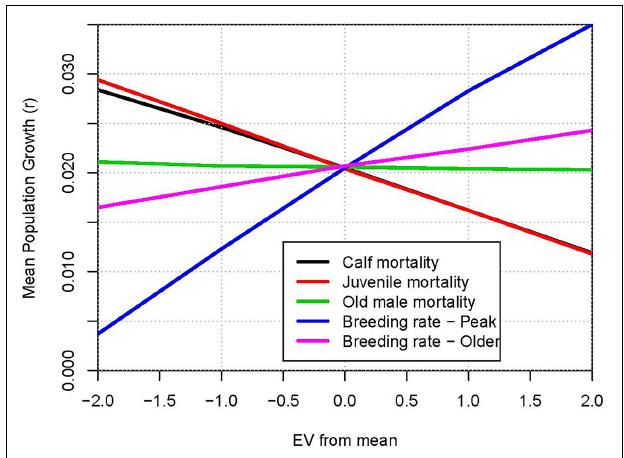
FIGURE 8 | Relative impacts of environmental variation in demographic rates: Population growth rate ( r ) when demographic rates are varied from − 2 EV to +2 EV around the mean estimated values. Lines from top to bottom on right hand ends: Breeding rate – Peak; Breeding rate – Older; Older male mortality (slope ≈ 0); Calf mortality; Juvenile